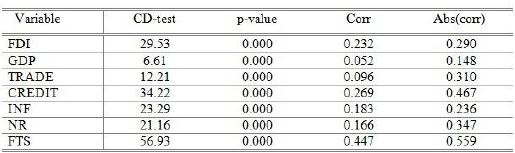
Table 3: Pesaran (2004) CD Test Outcomes